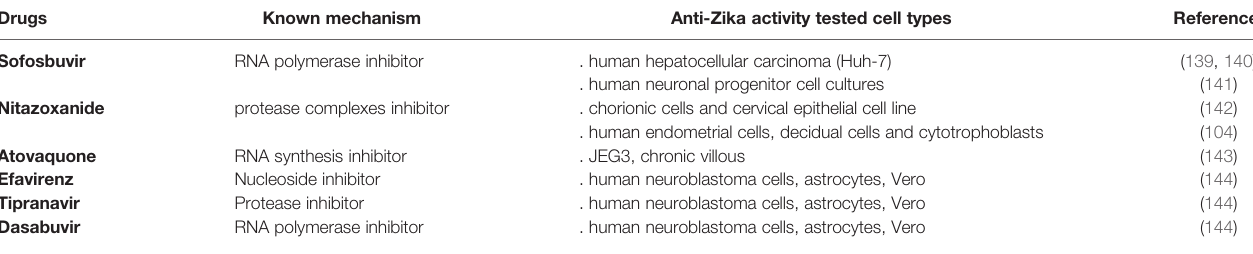
TABLE 1 | Summary of candidate anti-ZIKV drugs and their